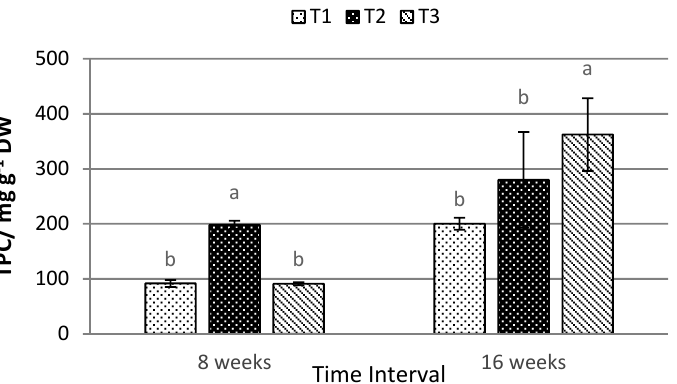
Figure 4. Effects of different shading levels on the total anthocyanin content of P. minus (data are means of treatments; N = 36; Rep = 3; Control, T1 = 0% Shading; T2 = 50% Shading; and, T3 = 70% Shading; DW = Dry Weight). Means with different letters on top of each bar are significantly different at p ≤ 0.05.